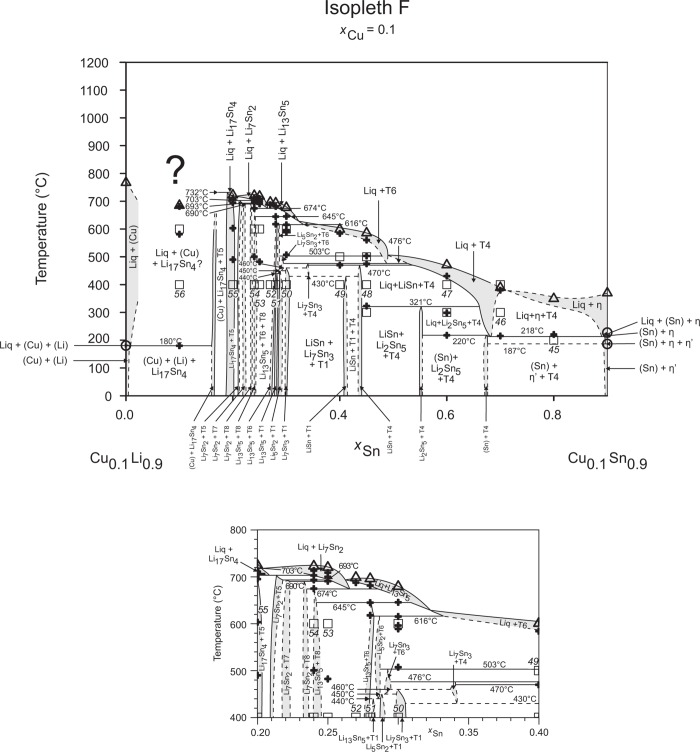
Isopleth F including section from xSn = 0.20–0.40 / T = 400–800°C.